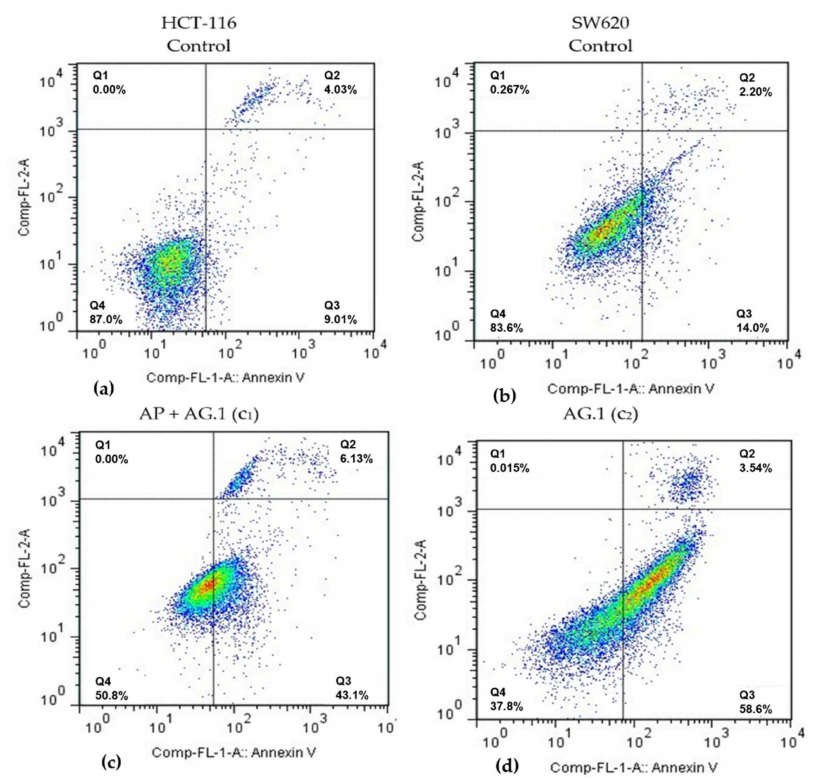
Figure 2. Representative diagrams of apoptotic cell diversification in HCT-116 and SW620 cells after treatment with ( c ) Agarikon Plus and Agarikon.1 (AP + AG.1) and ( d ) Agarikon.1 (AG.1) in comparison with ( a ) untreated HCT-116 and ( b ) SW620 cell lines. Quadrant legend: Q4 = lower left, An- / PI-, non-apoptotic; Q3 = lower right, An +/ PI, early apoptotic; Q2 = upper right, An +/ PI + , late apoptotic; Q1 = upper left, An- / PI + ,